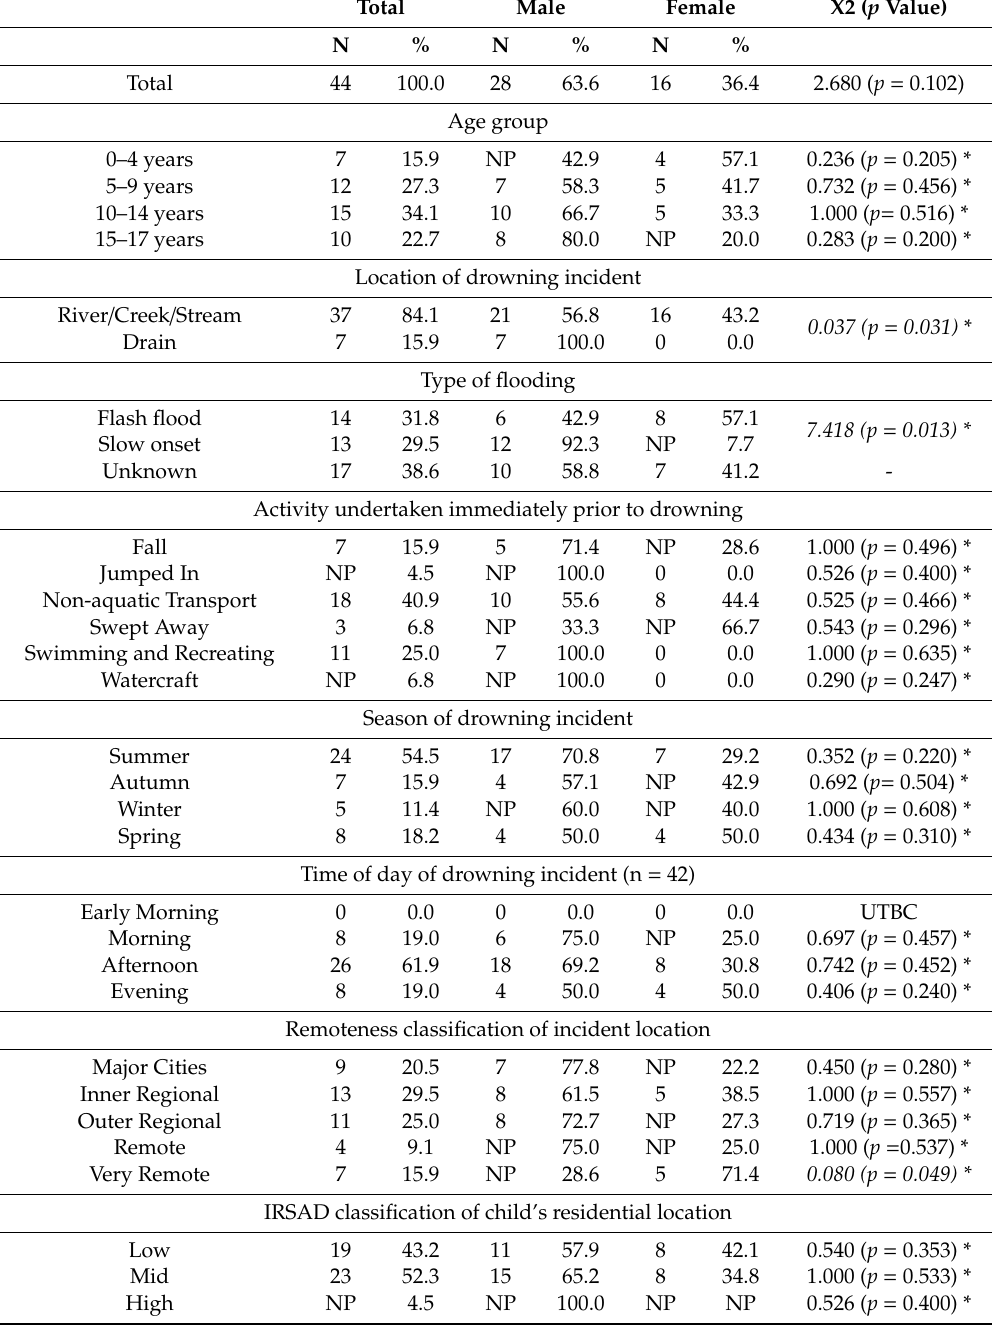
Table 1. Demographics and circumstances of child and adolescent unintentional flood-related drowning deaths by sex of drowning victim, Australia, 2002 / 03–2017 / 18 (N =